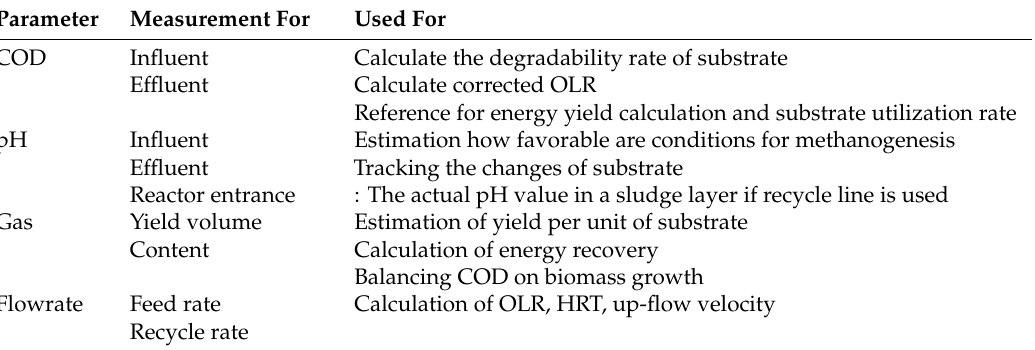
Table 6. Minimal list of parameters for tracking during UASB